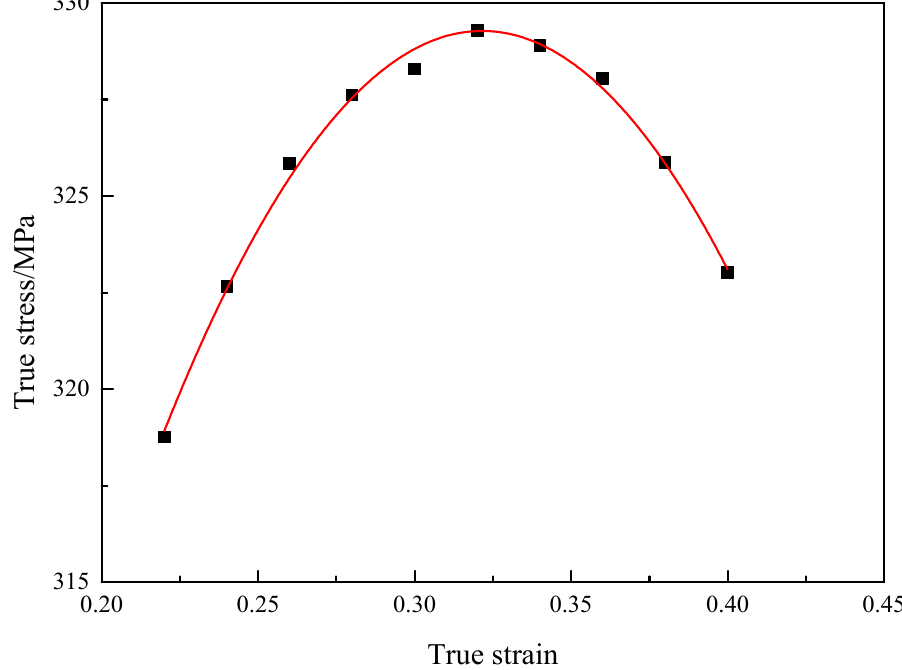
Figure 13. The individual parameters in the fifth polynomial of C( ε ) can be calculated by polynomial fitting, and the values of the parameters are shown in Table 3. Figure 11. The comparison of calculated values and experimental results of true stress of the HS model.